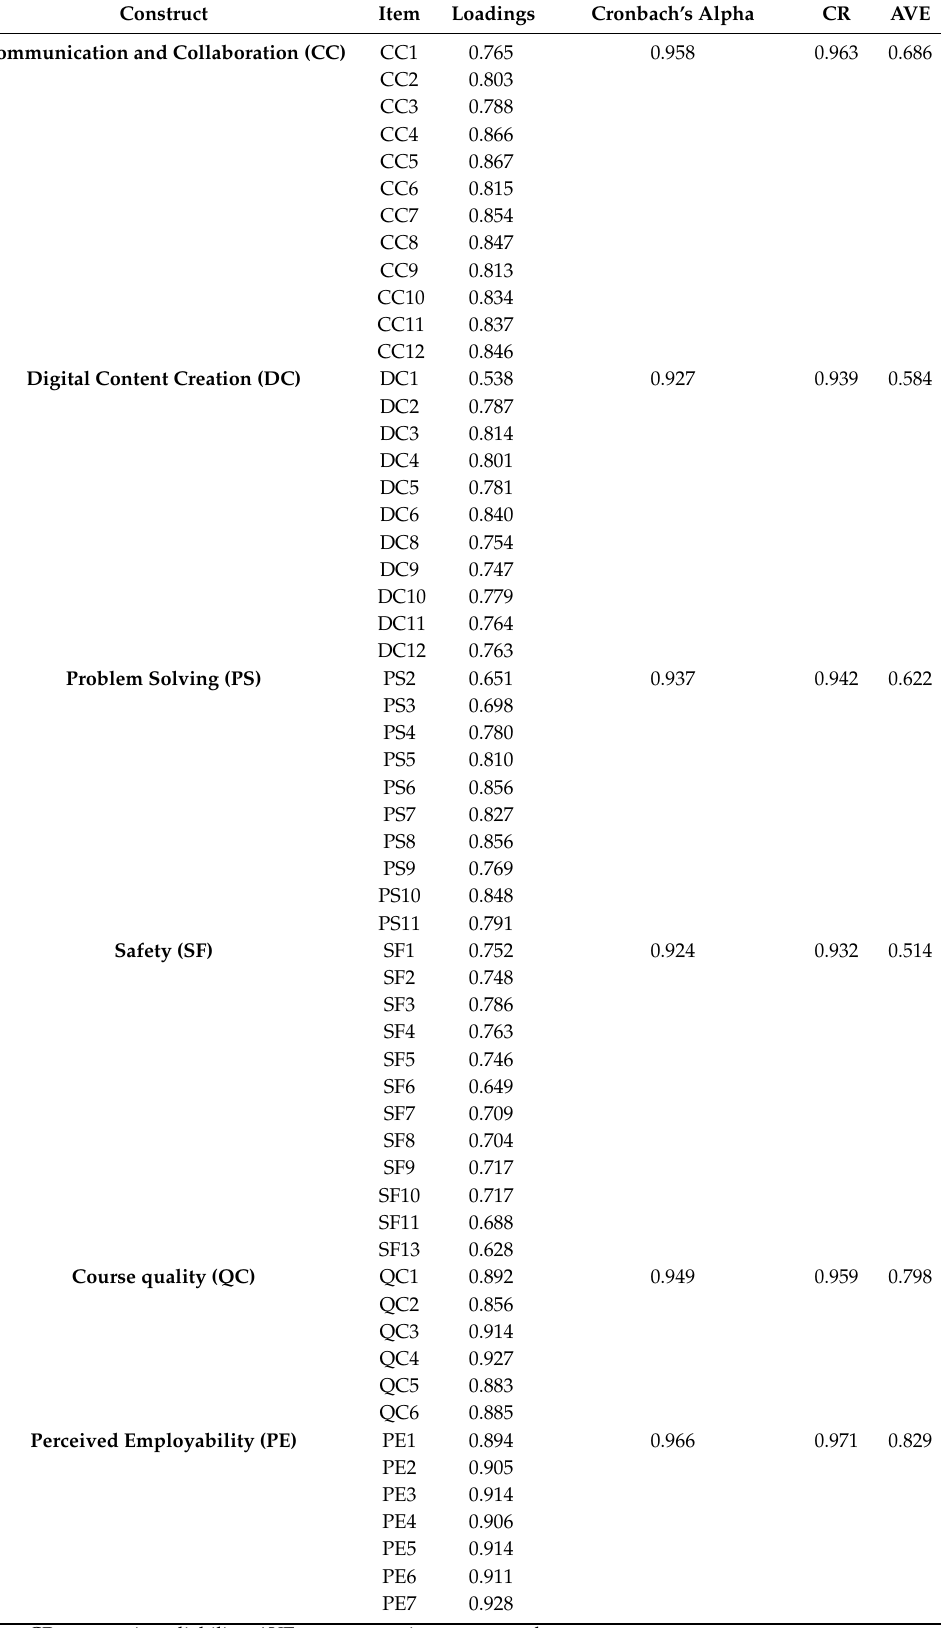
Table 1. Cont. Construct Item Loadings Cronbach’s Alpha CR AVE Communication and Collaboration